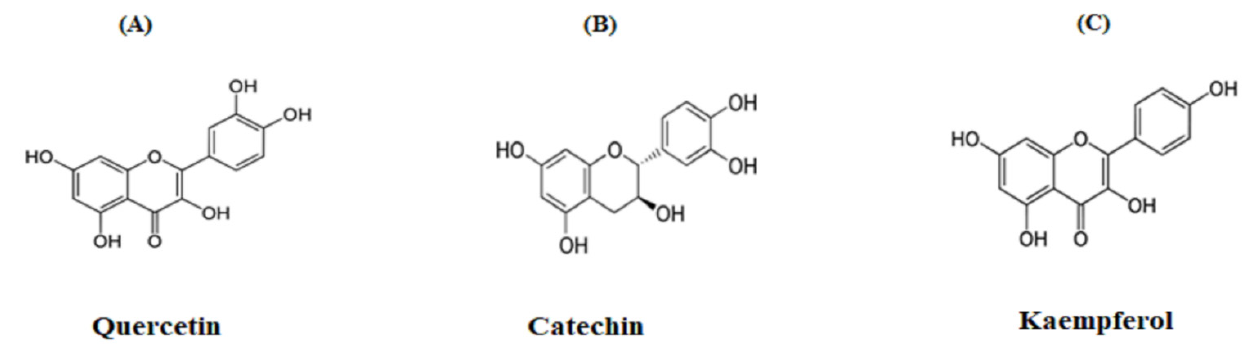
Figure 8. Isolated compounds ( A ) quercetin, ( B ) catechin and ( C ) kaempferol of Peak-1, -2 and -3 samples obtained from RP-HPLC of hot-water extract of A. arabica bark via LC-MS analysis. Proton-decoupled natural abundance 1 H-NMR and C 13 -NMR of the Peak-1 sample of A. arabica bark (obtained from a chromatograph over the period of 70% acetonitrile from 10 to 40 min with a retention time of 9.7 min) at 40 °C. The spectrum values were obtained at 600 MHz after 119,044 transients (14 h) by the pulsed Fourier-transform method on a Varian XL-100 A spectrometer. The representative structures of flavonoids, corresponding to the molecular formula of quercetin, catechin and kaempferol, are C 15 H 10 O 7, C 15 H 14 O 6 and C 15 H 10 O 6.